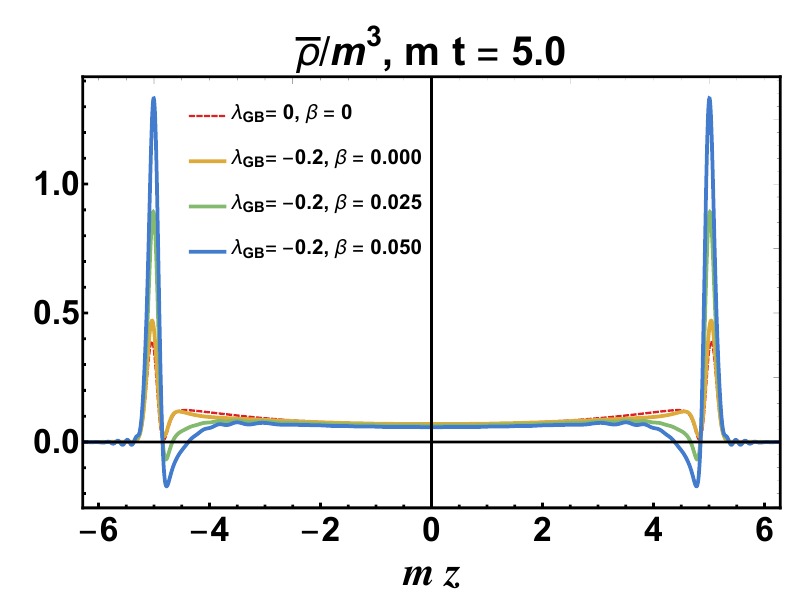
Figure 6 . (cid:12) -dependence of the baryon number density after a collision between thin sheets at the late time t = 5 =m with (cid:15) = 0, plotted as a function of mz .